Question: Produce a descriptive caption suitable for publication.
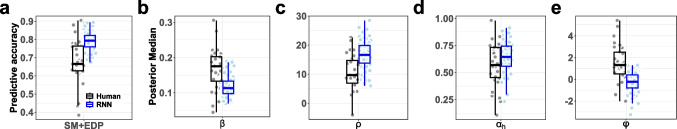
Answer: Median posterior values of model parameters for the best-fitting model (Bayesian learner with exploration and higher order perseveration terms, SM + EDP). ( a ) Predictive accuracy as the fraction of choices correctly predicted by the fitted computational model of behavior, ( b ) choice stochasticity parameter β, ( c ) perseveration parameter \documentclass[12pt]{minimal} \usepackage{amsmath} \usepackage{wasysym} \usepackage{amsfonts} \usepackage{amssymb} \usepackage{amsbsy} \usepackage{mathrsfs} \usepackage{upgreek} \setlength{\oddsidemargin}{-69pt} \begin{document}$$\uprho$$\end{document} ρ , ( d ) Habit step size parameter \documentclass[12pt]{minimal} \usepackage{amsmath} \usepackage{wasysym} \usepackage{amsfonts} \usepackage{amssymb} \usepackage{amsbsy} \usepackage{mathrsfs} \usepackage{upgreek} \setlength{\oddsidemargin}{-69pt} \begin{document}$${\mathrm{\alpha }}_{{\mathrm{h}}}$$\end{document} α h , ( e ) exploration parameter \documentclass[12pt]{minimal} \usepackage{amsmath} \usepackage{wasysym} \usepackage{amsfonts} \usepackage{amssymb} \usepackage{amsbsy} \usepackage{mathrsfs} \usepackage{upgreek} \setlength{\oddsidemargin}{-69pt} \begin{document}$$\mathrm{\varphi }$$\end{document} φ for human learners (black) and RNNs (blue)